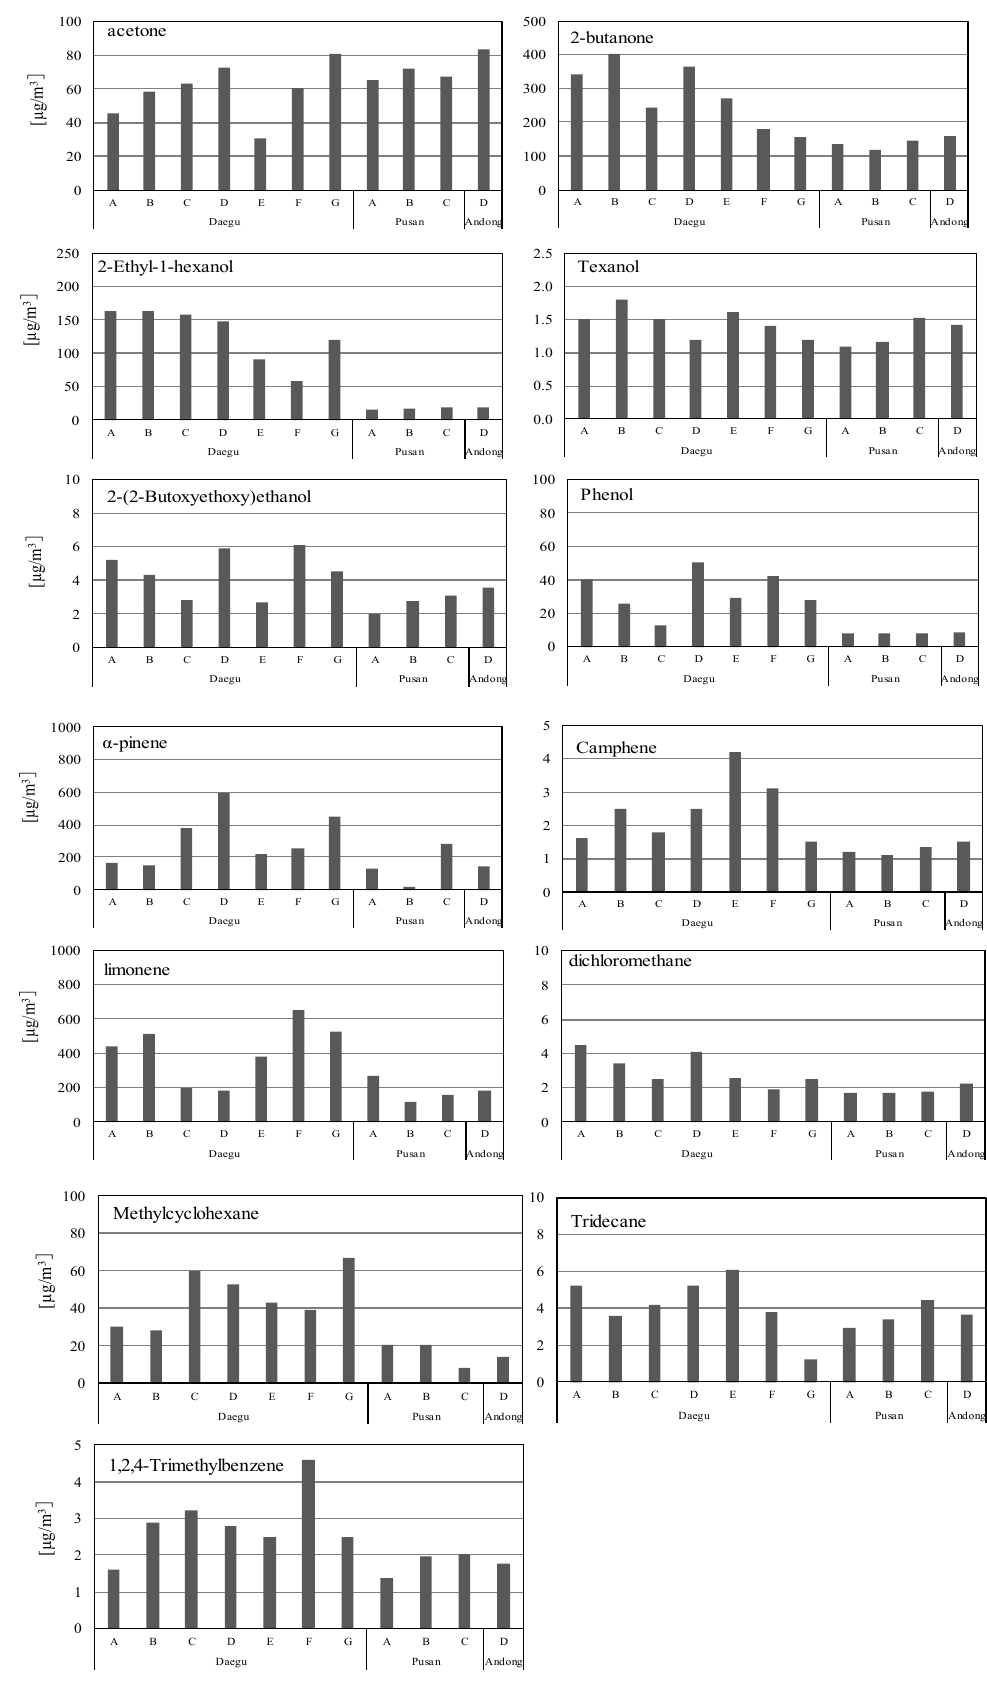
Figure 1. The concentrations of chemical substances measured in the air.